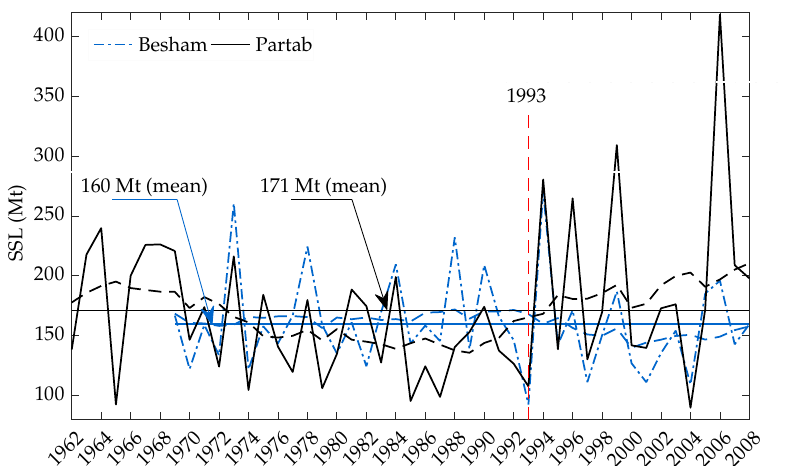
Figure 4. WA-ANN reconstructed annual suspended sediment loads (SSLs) for Besham Qila and Partab Bridge gauge stations showing an increase after 1993 at Partab Bridge (the dashed lines represent the 10-year moving average).